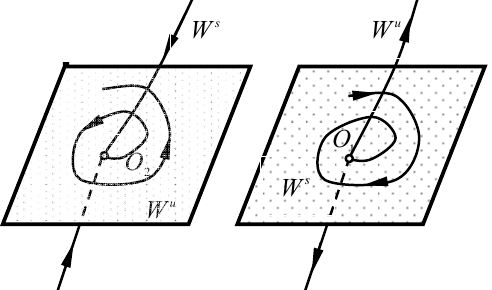
Figure 1. Depicted are the fixed points of saddle-focus type of system (1). Left panel: unstable focus (complex eigenvalues with positive real part). Right panel: stable focus (complex eigenvalues with negative real part).